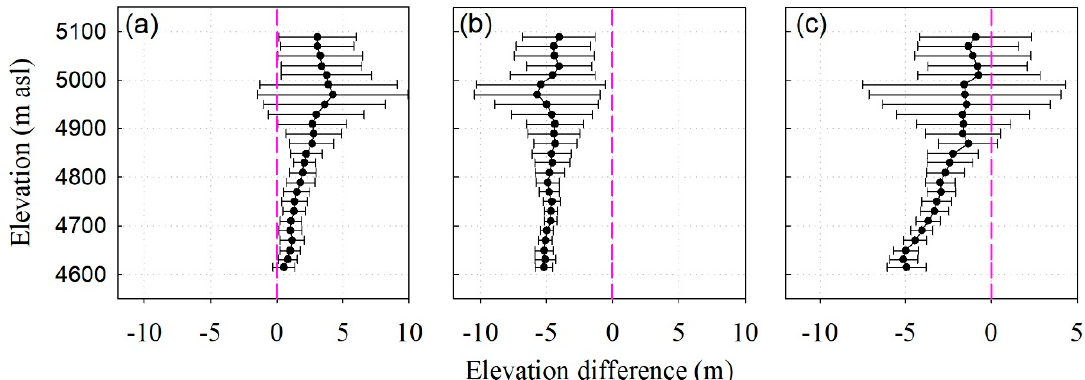
Figure 7. Mean glacier surface elevation changes within 20-m elevation bands (black dots) with the corresponding standard deviations (grey horizontal error bar) for cold season ( a ), warm season ( b ) and annual scale ( c ) at the ablation zone of Parlung No. 4 Glacier.